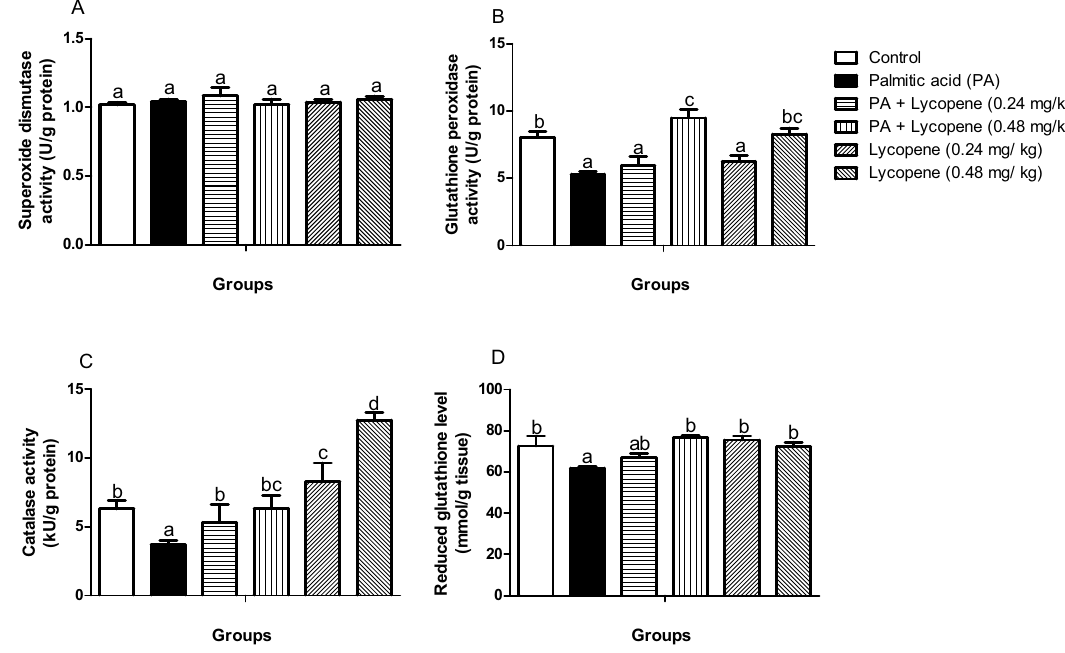
Figure 3. Effects of lycopene on the activities of antioxidant markers of palmitic acid-induced neuro- inflammation in female rats. Values are expressed as mean ± S.E.M (n = 5). Bars with different letters are statistically distinct (p < 0.05). ( A ) Superoxide dismutase activity ( B ) Glutathione peroxidase activity ( C ) Catalase activity ( D ) Reduced glutathione level. Data were analysed using SPSS version 20 (IBM SPSS Software, United Kingdom) while the graph was plotted using GraphPad Prism Software, version 6 (San Diego, CA 92,108) https:// www. graph pad. com/ scien tific- softw are/